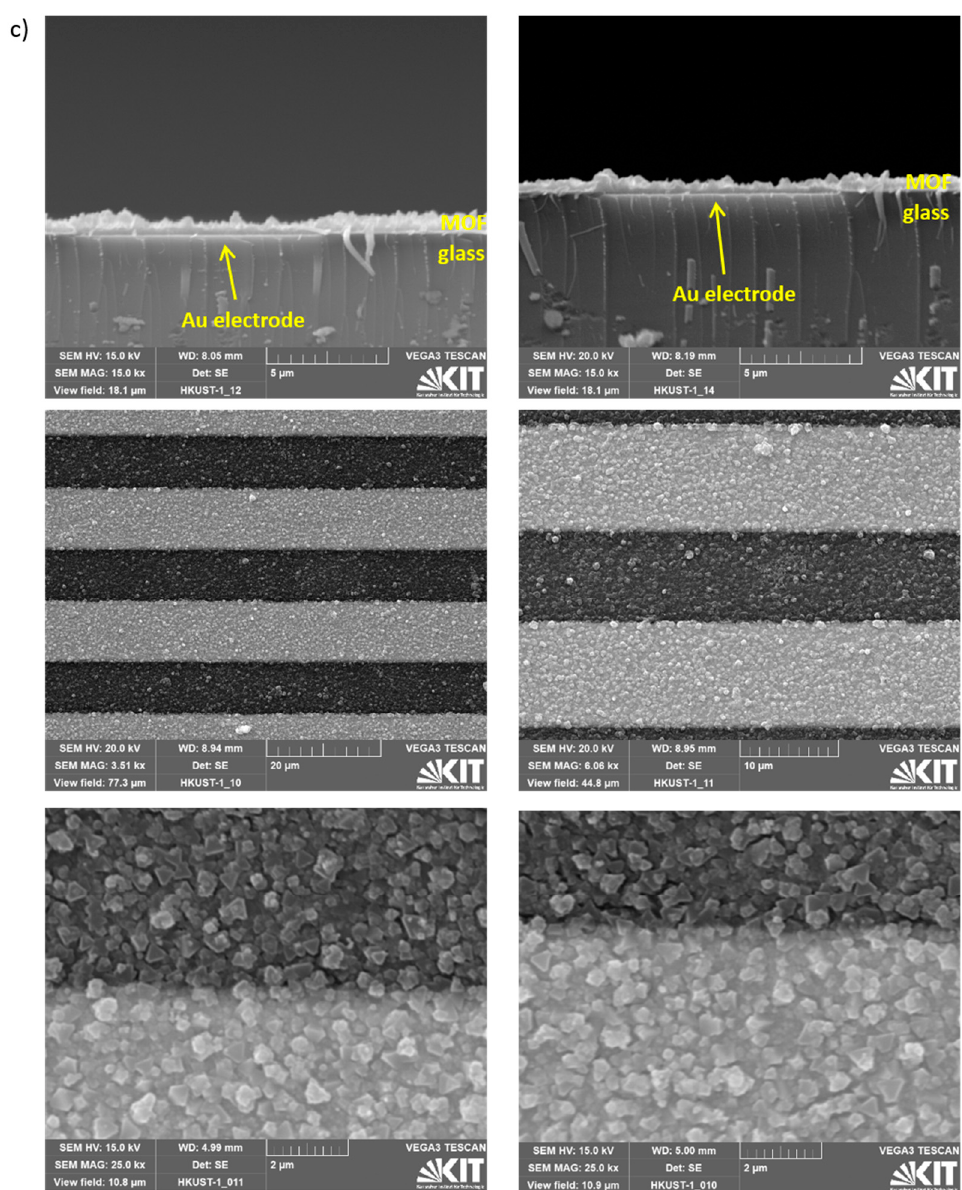
Figure A6. SEM images of the samples used in Figure 5. Cross-sections of the broken samples and top views of the samples are shown. The samples are HKUST-1 SURMOFs, grown on the IDE-substrates upon functionalization with MHDA ( a ), with MUD ( b ), and by UV-ozone treatment ( c ). The thicknesses of all 3 samples are 0.5 ± 0.1 µm, determined from the cross-section pictures.